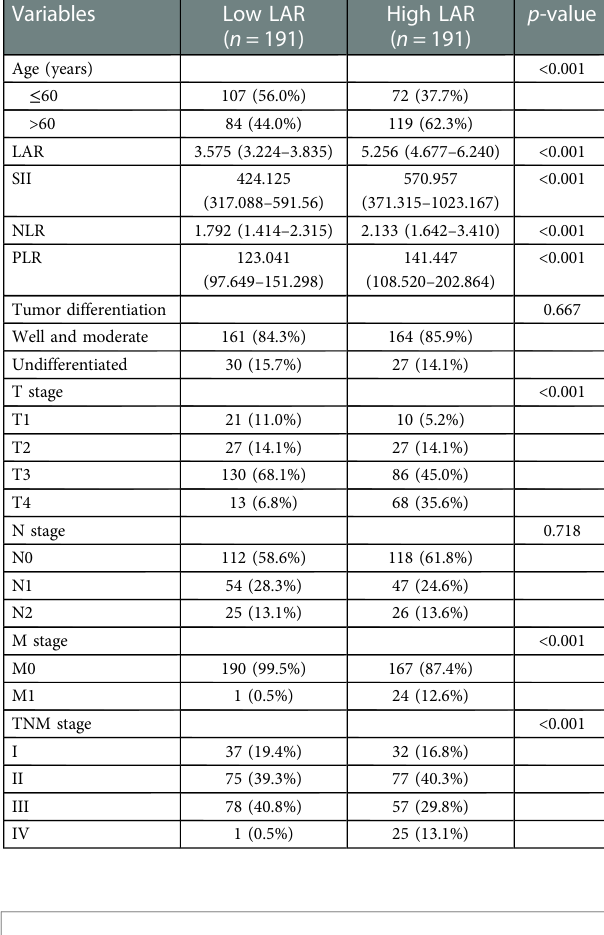
TABLE 5 Correlation between LAR and clinicopathological features in all CRC patients.